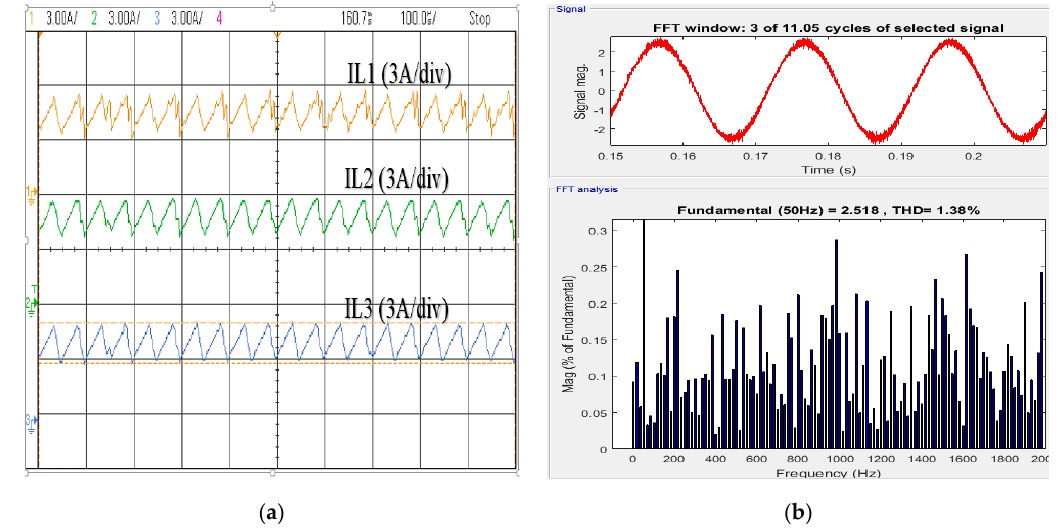
Figure 18. Experimental result for ( a ) inductor current for each input, ( b ) load current and its harmonics contents showing a total harmonic distortion (THD) of about 1.38%.